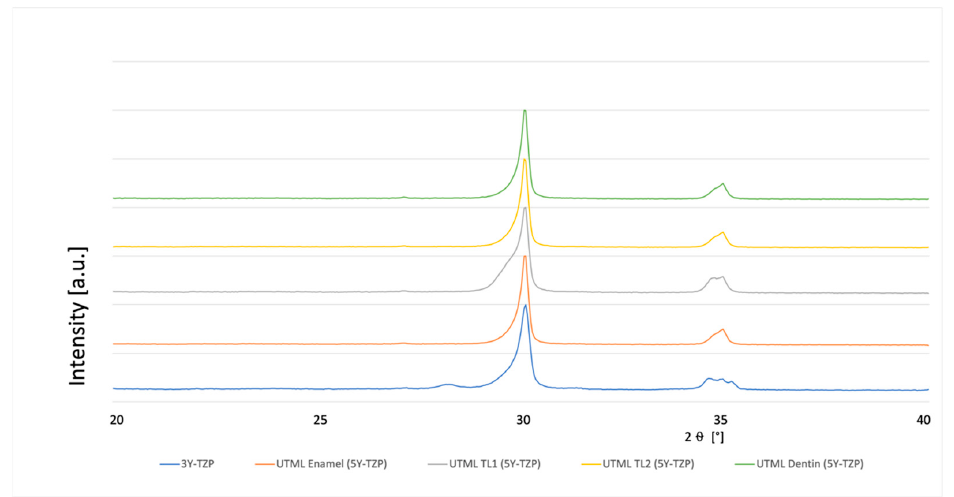
Figure 8. XRD analysis 3Y-TZP and 5Y-PSZ 600 Grit and pre-sintered at cutting.